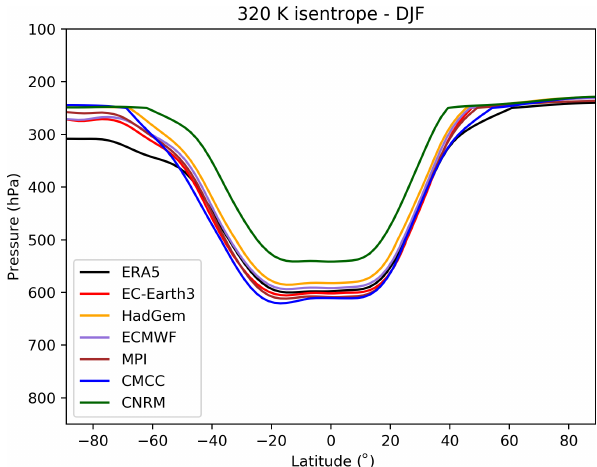
Figure A1. Pressure height (in hPa) of the 320K isentropic sur- face (time-zonal mean for DJF). The black line is ERA5, and other colours are PRIMAVERA LR